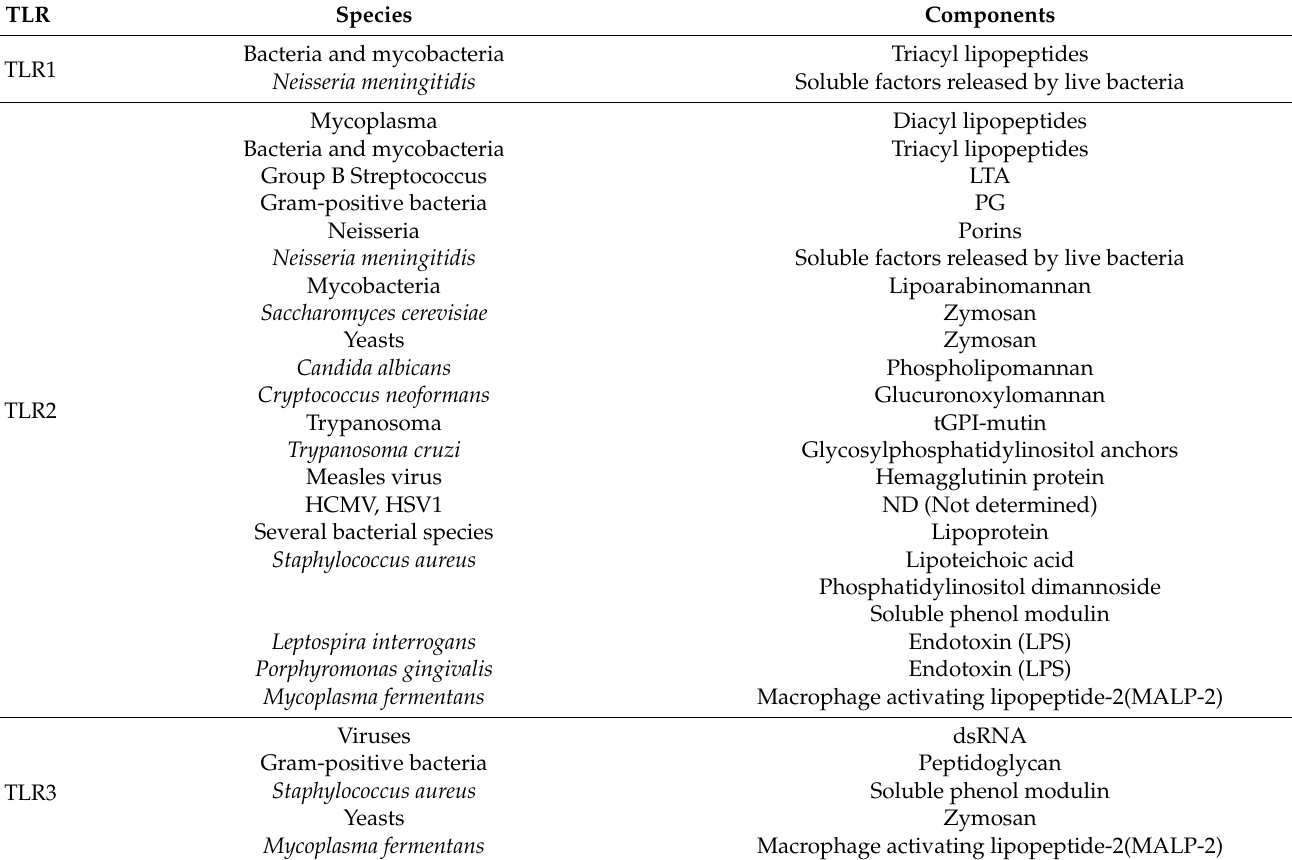
Table 1. TLR recognition of microbial